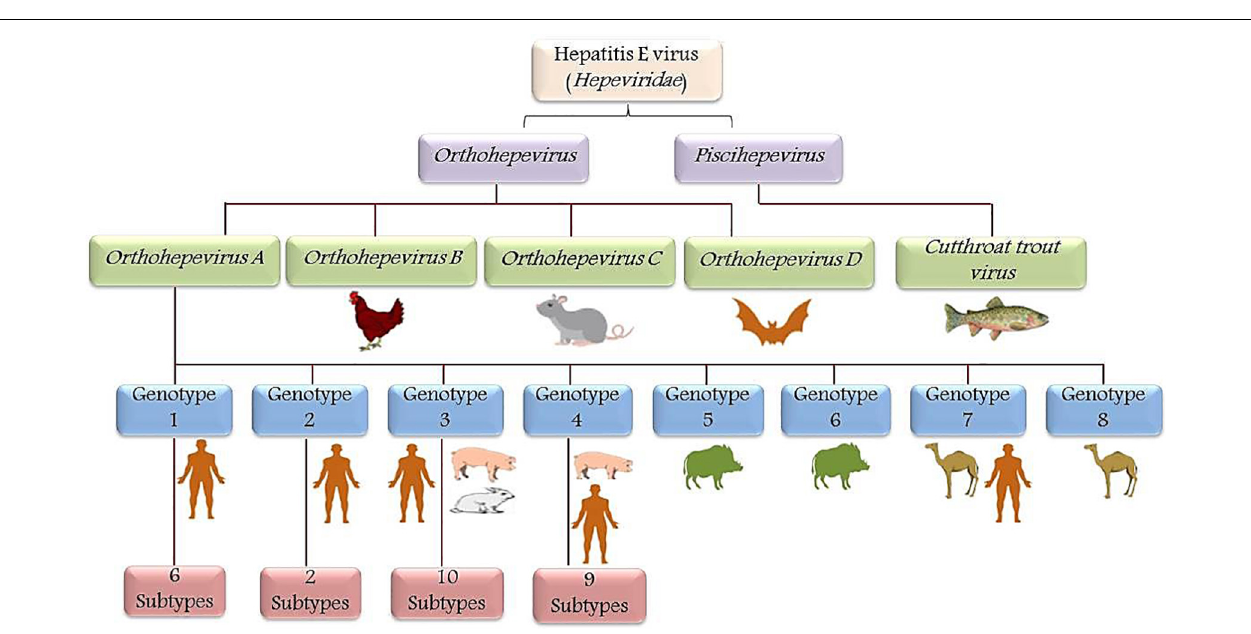
FIGURE 2 | Schematic representation of HEV taxonomy: Hepeviridae family is classified into genera Orthohepevirus and Piscihepevirus . Orthohepevirus is comprised of four species viz. Orthohepevirus-A , Orthohepevirus-B , Orthohepevirus-C, and Orthohepevirus-D based on the host range and sequence identities, whereas Piscihepevirus genus includes only the Cutthroat trout virus (CTV). In Orthohepevirus-A species, eight genotypes were identified and designated as HEV genotype (HEV-1 to HEV-8). Genotype-1 (six subtypes) and genotype-2 (two subtypes) are mainly confined to humans. However, genotype-3 (10 subtypes) and genotype-4 (9 subtypes) infects swine but are also known to be transmitted to humans by the consumption of meat (zoonotic). Genotype-5 and genotype-6 are identified in wild boars. Recently genotype-7 and genotype-8 were identified in the dromedary and Bactrian camel,